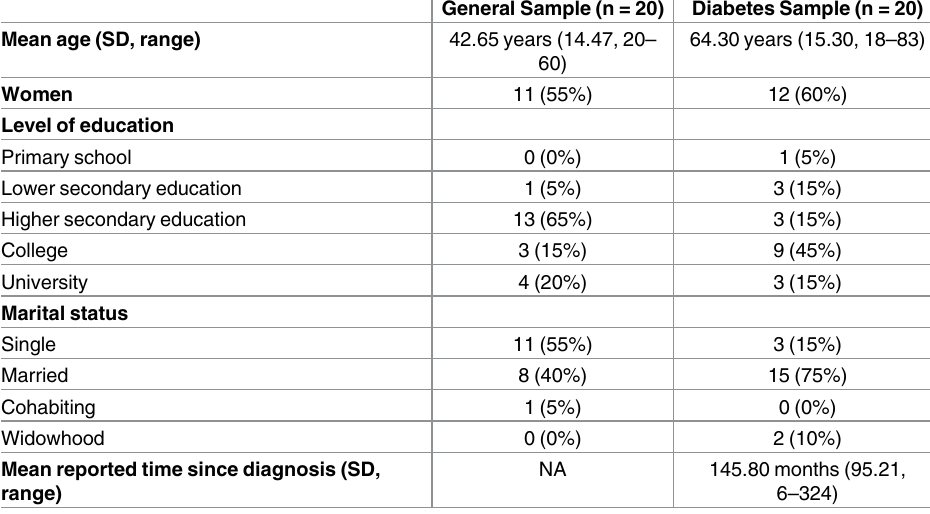
Table 1. Demographic information.